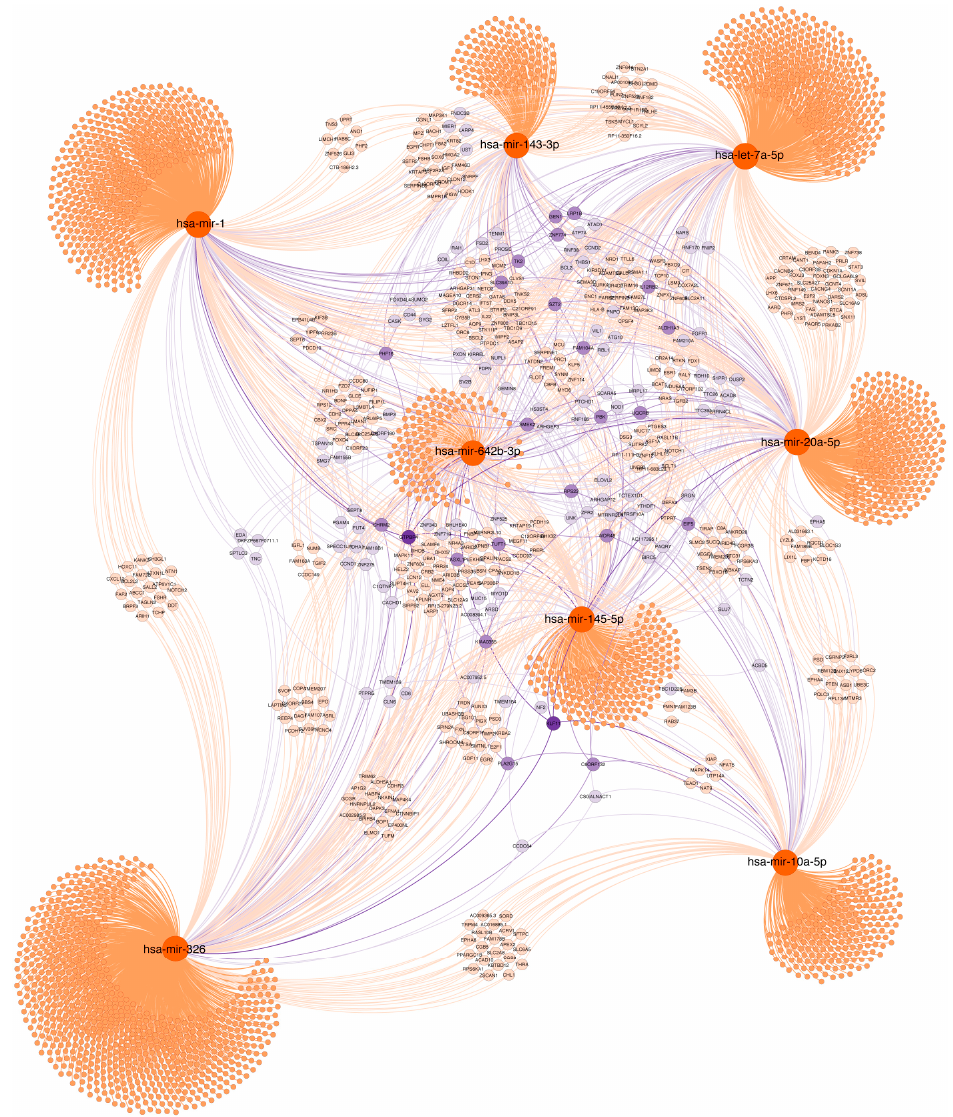
Figure 7. Target gene network of validated miRNAs associated with biopsy histopathological features. Selected miRNAs are highlighted in orange. Genes with at least two potential interactions were labelled. Genes with just one connection are unlabelled. Colour nodes of regulated genes are proportional to node degree (number of connections).